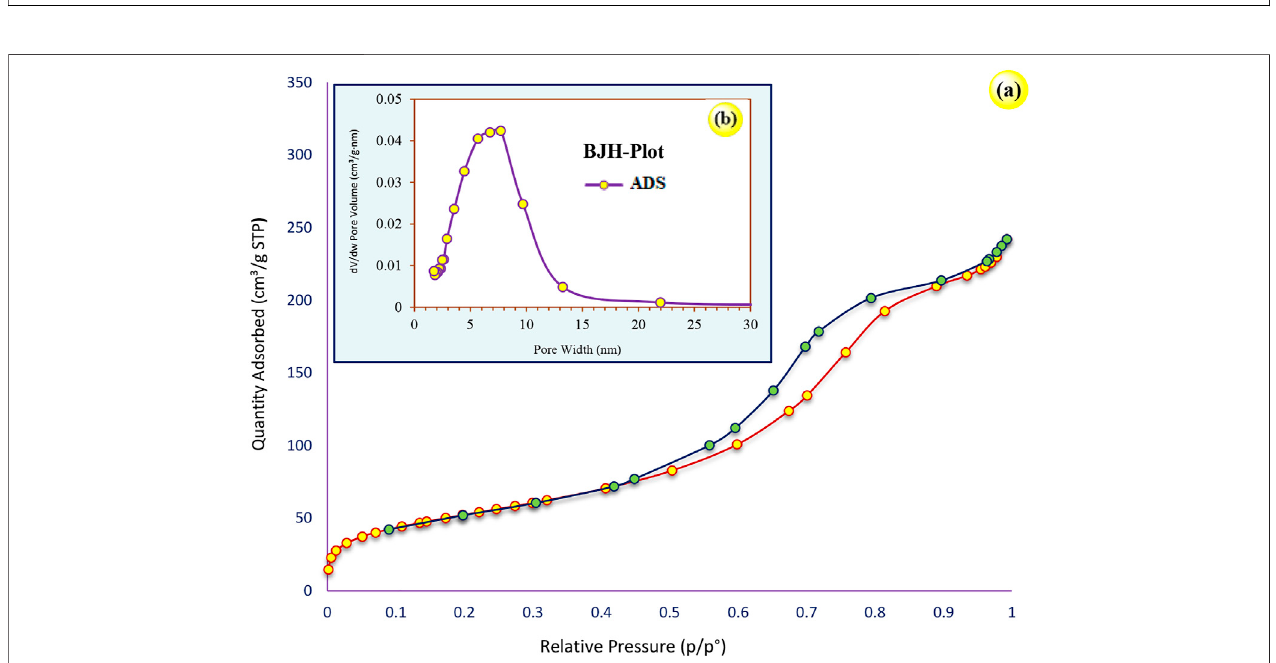
FIGURE 4 | (A) Adsorption – desorption N 2 isotherms and (B) pore size distribution of Pd/TCH-pr@SBA-15.